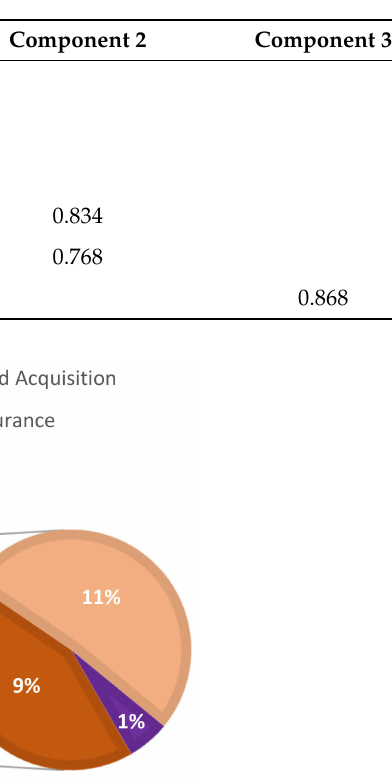
Table 9. Rotated Component Matrix.